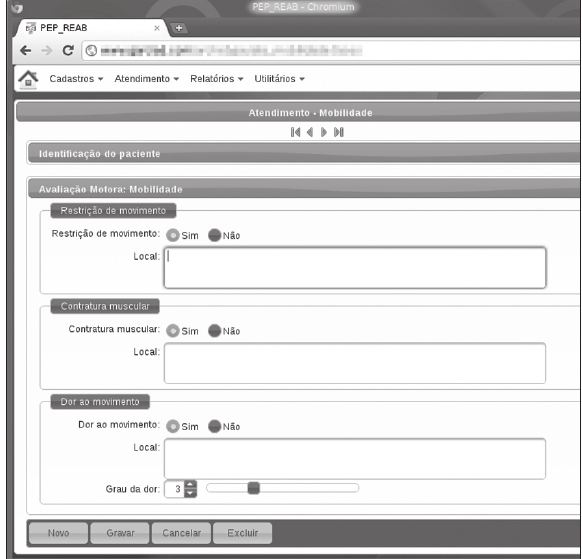
Figura 4 - Protótipo elaborado a partir do arquétipo "Mobilidade" Fonte: Dados da pesquisa.